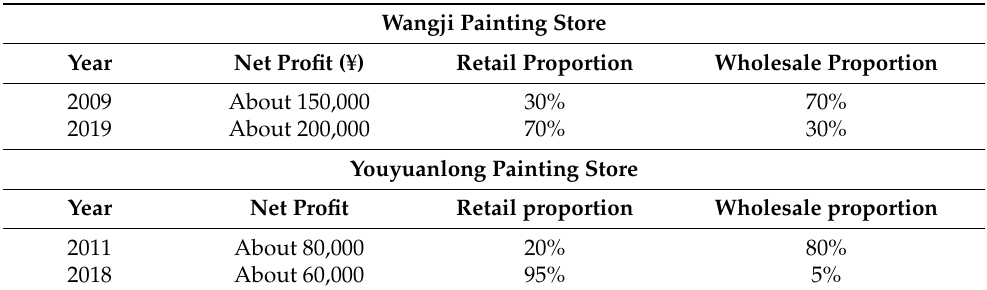
Table 1. Wangji Painting Store and Youyuanlong Painting Store sales